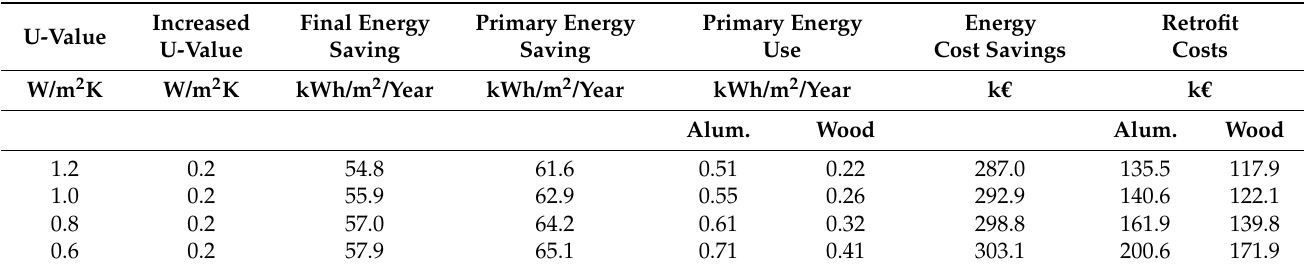
Table 5. Final and primary energy savings, energy cost savings, and retrofit costs of new windows using aluminum and wood frames with equally improved